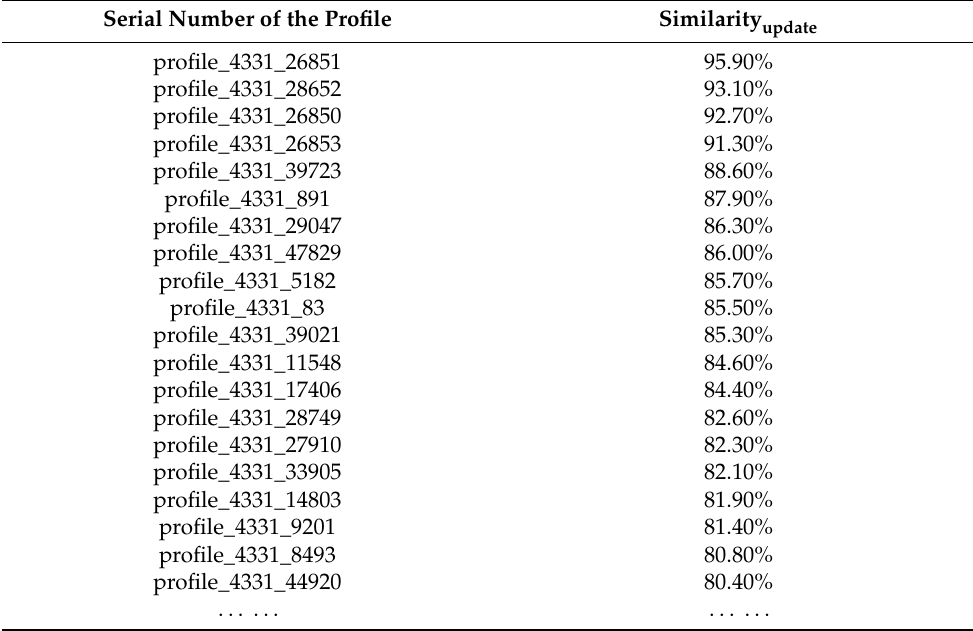
Table 3. Similarity matching results for 1-m interval topographic profiles sequence